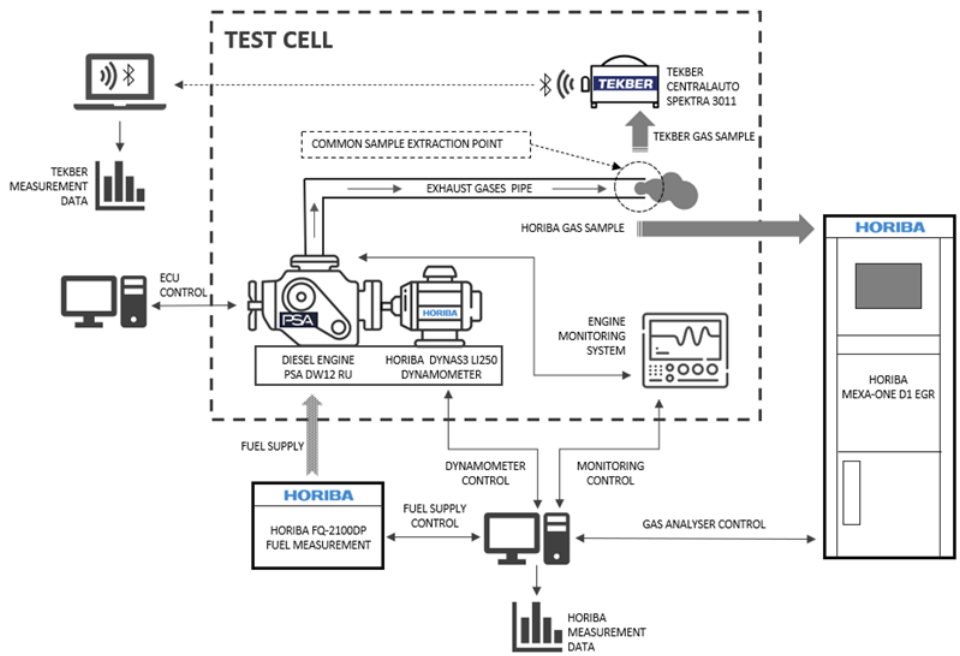
Figure 1. Test cell schema with Tekber and Horiba Gas Analyser Figure 1 . Test cell schema with Tekber and Horiba Gas Analyser installation.